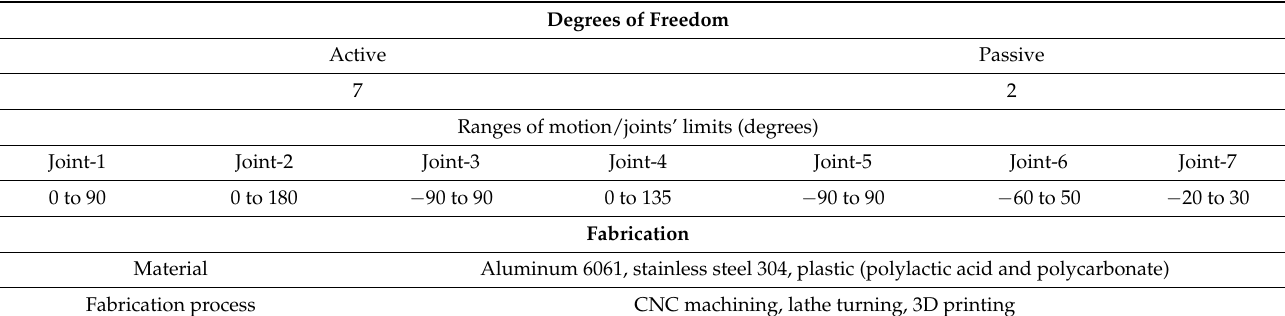
Table 2. Design specifications and selected components of the developed